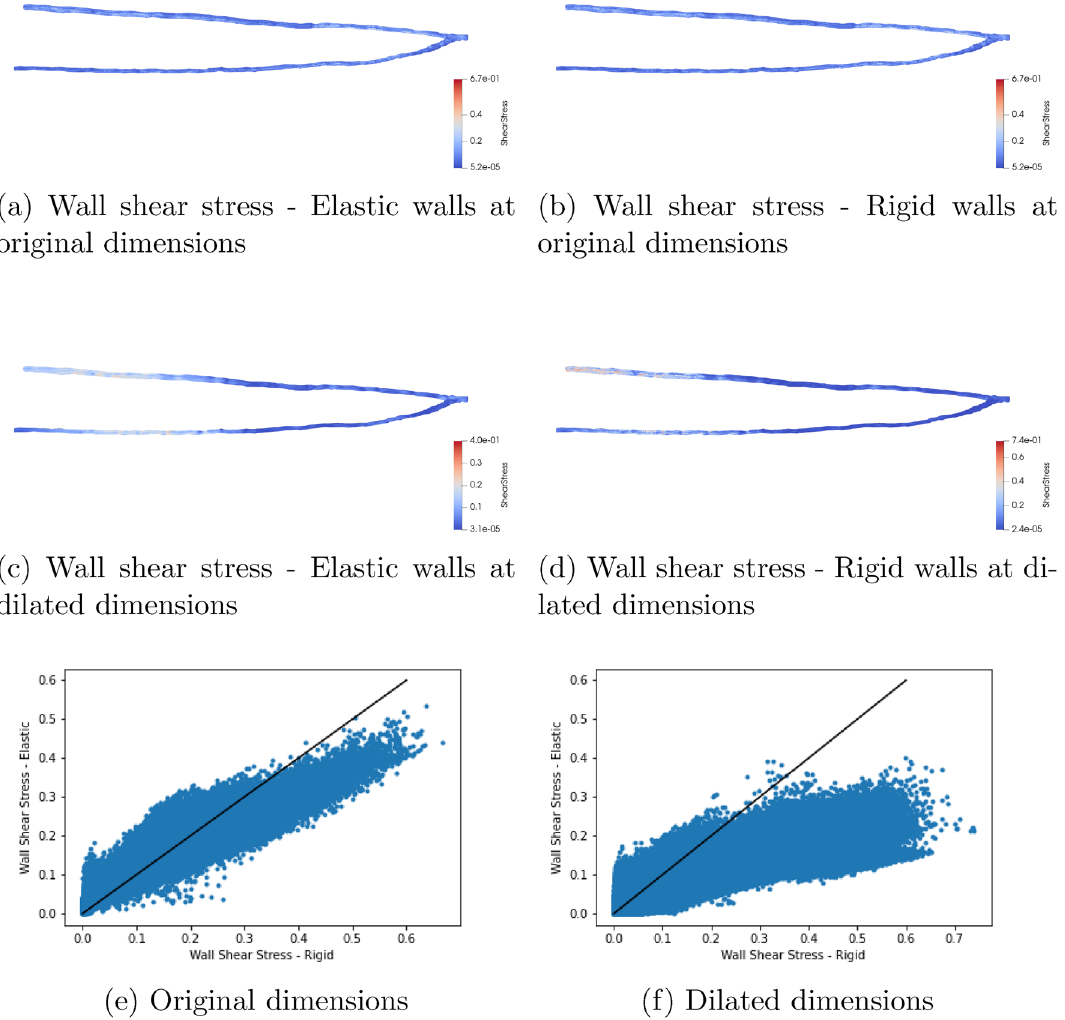
Figure 7. Wall shear stress fields for the arterial domain in their original ( a , b ) and dilated ( c , d ) dimensions after approximately 60% of the total simulation time. In figures ( e , f ) we present a pointwise comparison of instantaneous wall shear stress seen across the full domain of the arterial geometry in the rigid and elastic walled cases, the solid line represents the identity line. The shape of the plot—generally recording higher wall shear stress in the rigid walled case, especially at higher stress magnitudes—is consistent with that generated in other work using a fully coupled elastic wall model 28 . This result further demonstrates that our model is able to generate the elastic wall behaviour expected from a fully coupled approach whilst retaining the performance characteristics of a rigid wall implementation. The greater discrepancy between the rigid and elastic shear stresses in the dilated case also indicates how the choice of a larger boundary velocity ratio provides a more elastic